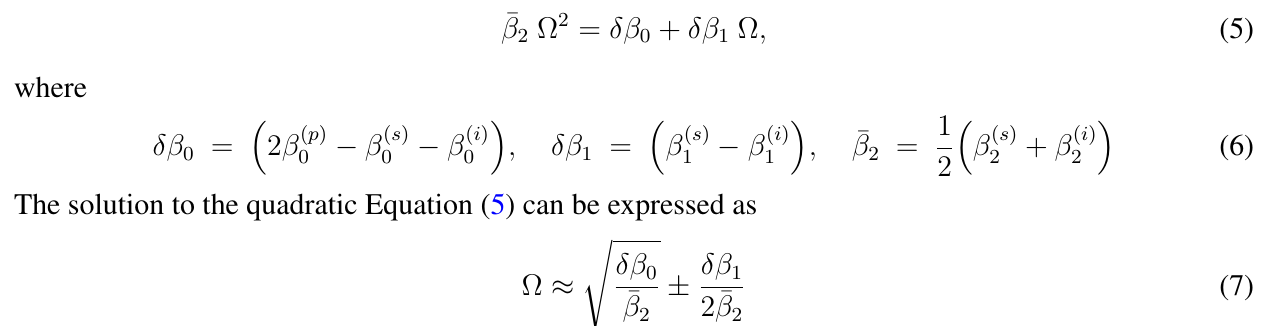
= 2 ω ; ( b ) In scenario (b) , the input p s , ω ) pair, where i s = 2 ω = 0 , , ω ) pair and ω results in ω i p i p s